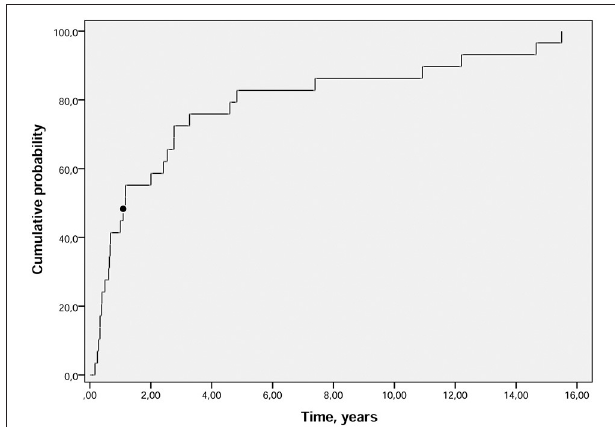
FIGURE 1 | Cumulative probability plot of time (years) from PR diagnosis to RA onset. The median time between PR onset and RA onset was 1.2 (black dot) years (p25–p75: 0.5–3.9). PR, palindromic rheumatism; RA, rheumatoid arthritis ( 34).